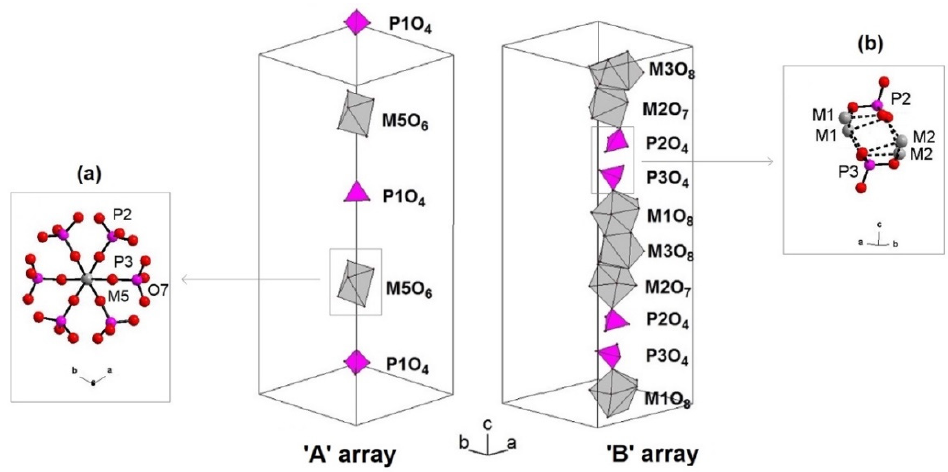
Figure 5. Ca 9 RE (PO 4 ) 7 packing: A and B arrays. Inset ( a ): detail of [M5(PO 4 ) 6 ] unit. Inset ( b ): joining mechanism among B arrays (M-O bonds dashed).